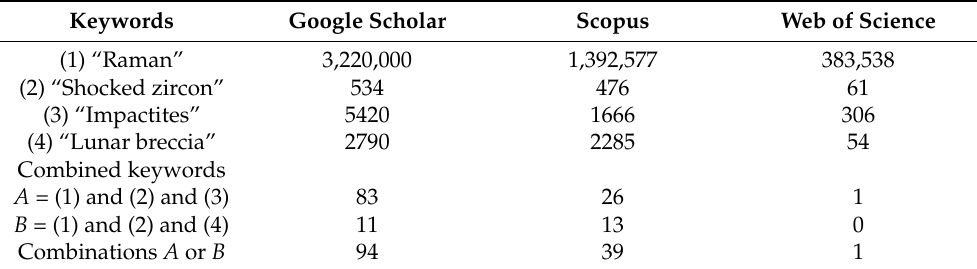
Table 1. Search strategy: number of hits on keywords and combined keywords in Google Scholar, Scopus, and Web of Science (Search: 5 April